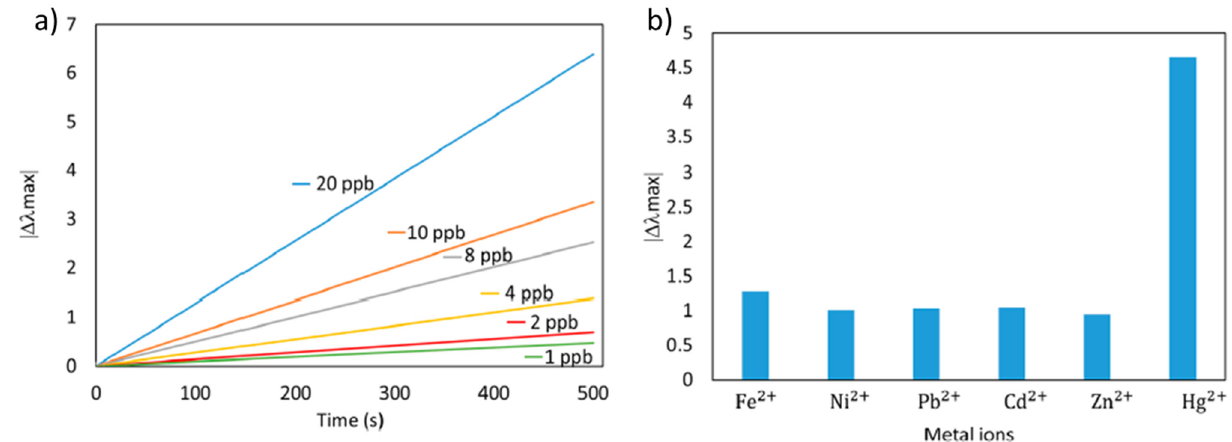
Figure 13. ( a ) Response of the LSPR optical fiber sensor for variable Hg concentration from 1 to 20 ppb; ( b ) Selectivity of the LSPR sensor against different heavy ions (Fe 2+ , Ni 2+ , Pb 2+ , Cd 2+ , Zn 2+ and Hg 2+ ). Reprinted with permission of [60].